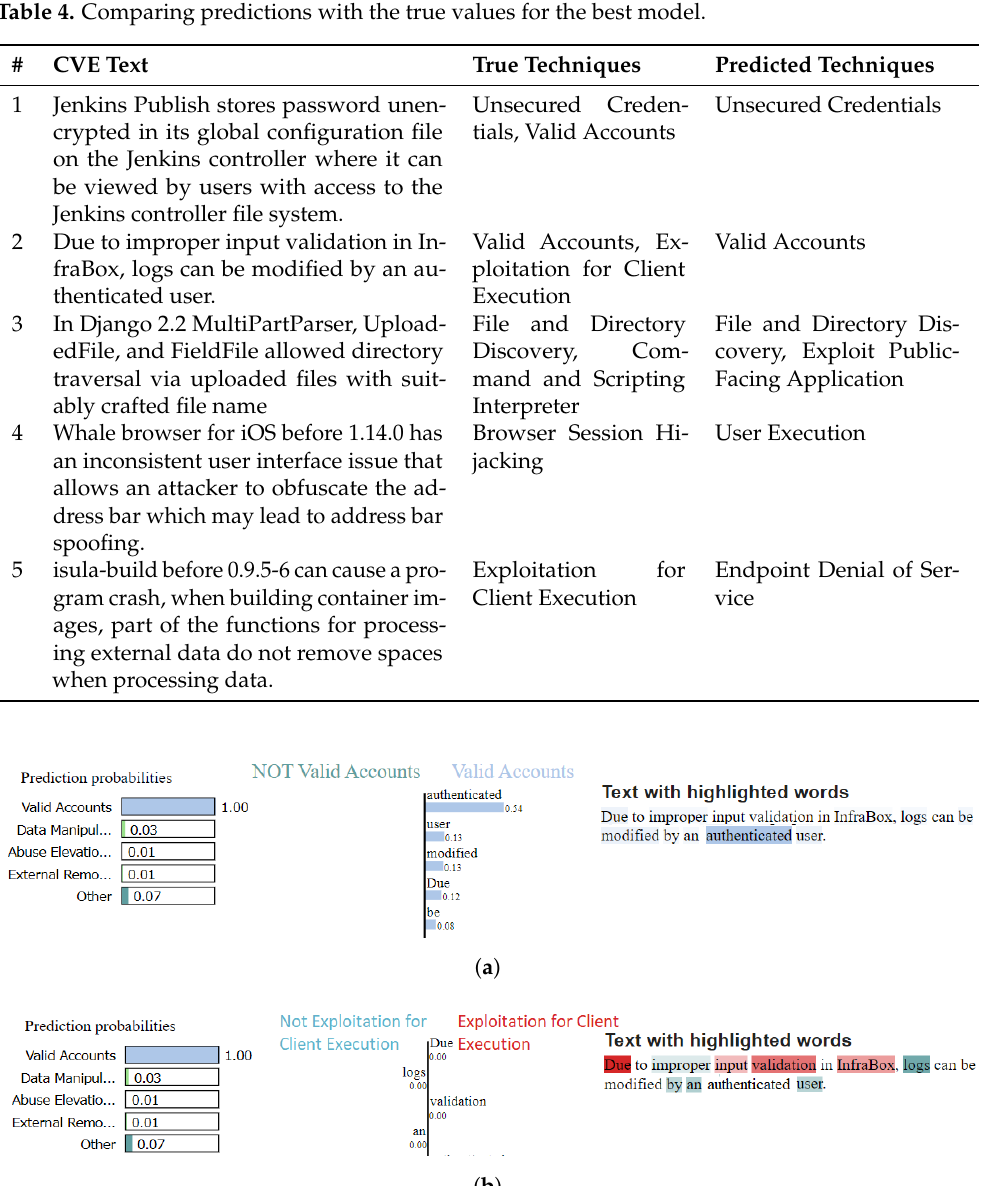
Table 4. Comparing predictions with the true values for the best model.